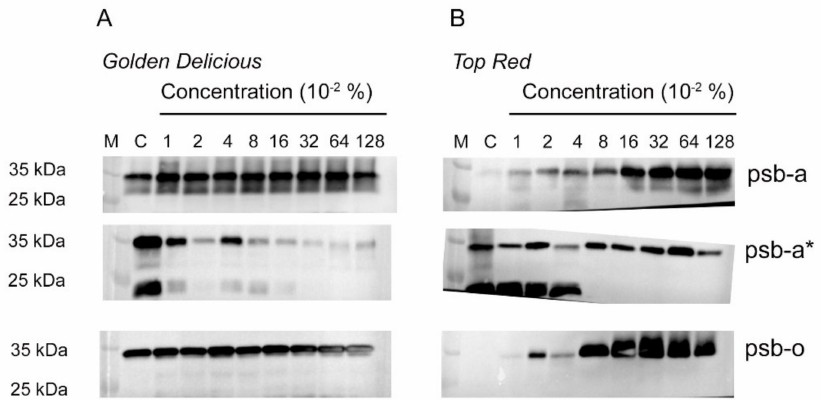
Figure 5. Western blot of three subunits of PSII for two apple cultivars exposed to a concentration gradient of the Brevis ® inhibitor. Panels ( A , B ) represent information for Golden Delicious and Top Red cultivars, respectively. Each sample includes three different leaf extracts. Psb-a, psb-a* and psb-o stand for D1, D1-phosphorylated and OEC-33 (Oxygen Evolving Center) subunits of PSII. M, C are Marker and Control (without Brevis),